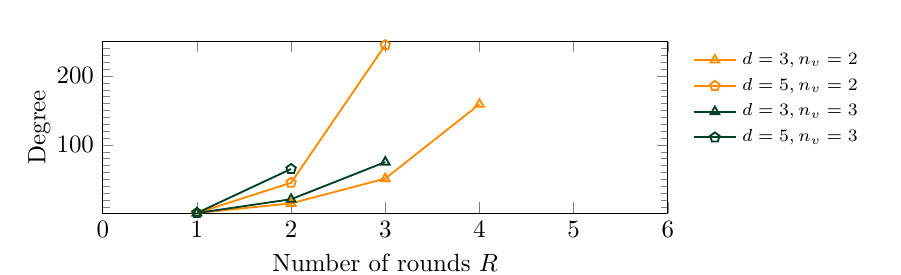
Figure 7: The values for D reg in practice, where d ∈ { 3 , 5 } , n v ∈ { 2 , 3 } , and n = n v + 1. We did not encounter any differences for n > n v + 1 in these